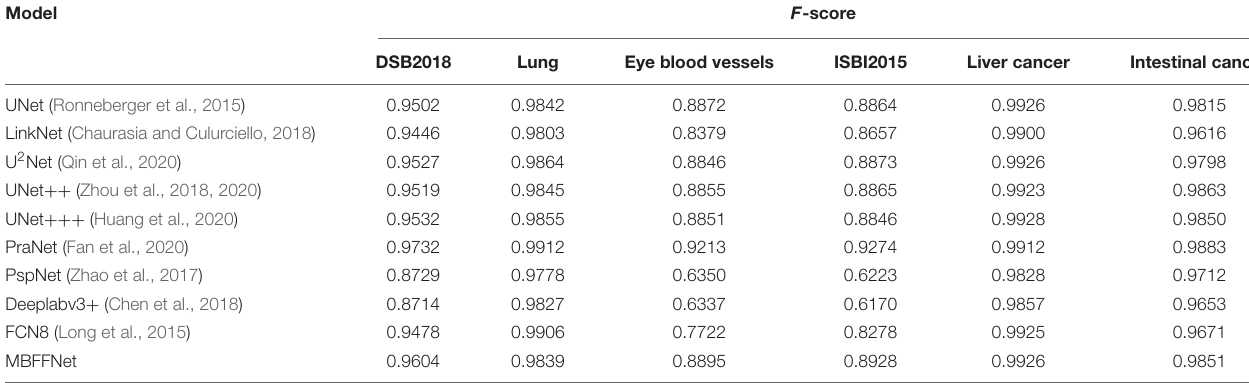
TABLE A2 | Multi-class medical image segmentation F -score evaluation index.